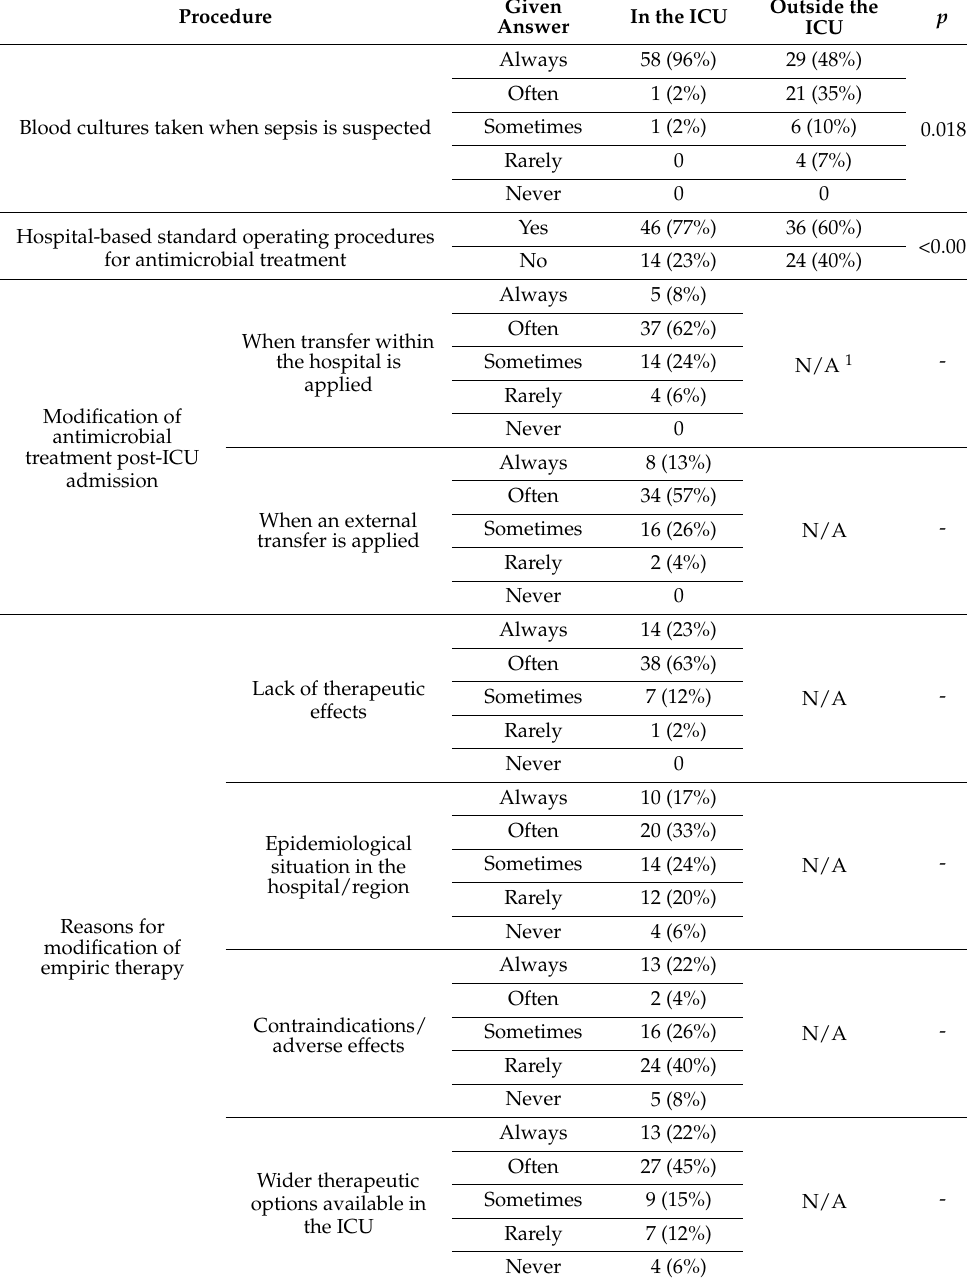
Table 2. Strategies regarding antimicrobial treatment in